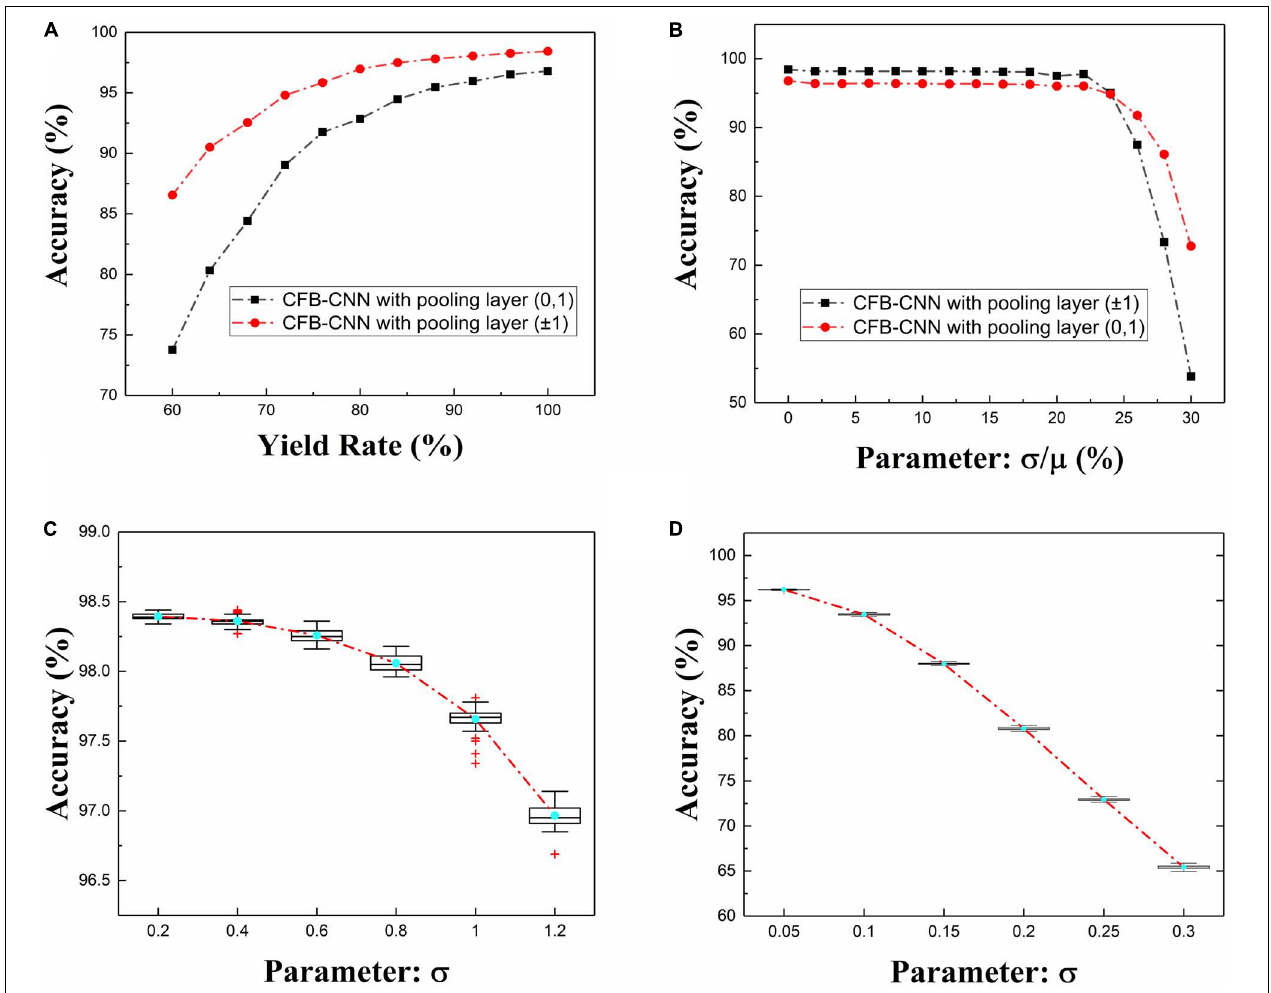
FIGURE 11 | The influence of device non-ideality on the recognition rate of the CFB-CNN architecture with pooling layer, (A) the influence of array yield on the recognition rate of the CFB-CNN architecture, (B) the influence of the memristance variation on the performance of the CFB-CNN architecture, (C,D) the influence of the neuron output variation on the recognition rate of the CFB-CNN architecture with pooling layer and hidden layer neurons configured as ± 1 or 0, 1, respectively.